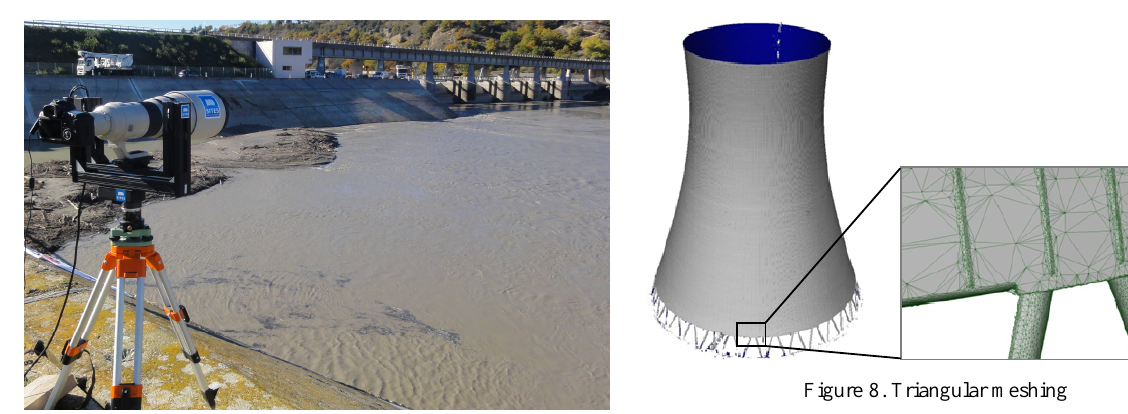
Figure 6. High resolution camera, 600 mm lens and panoramic